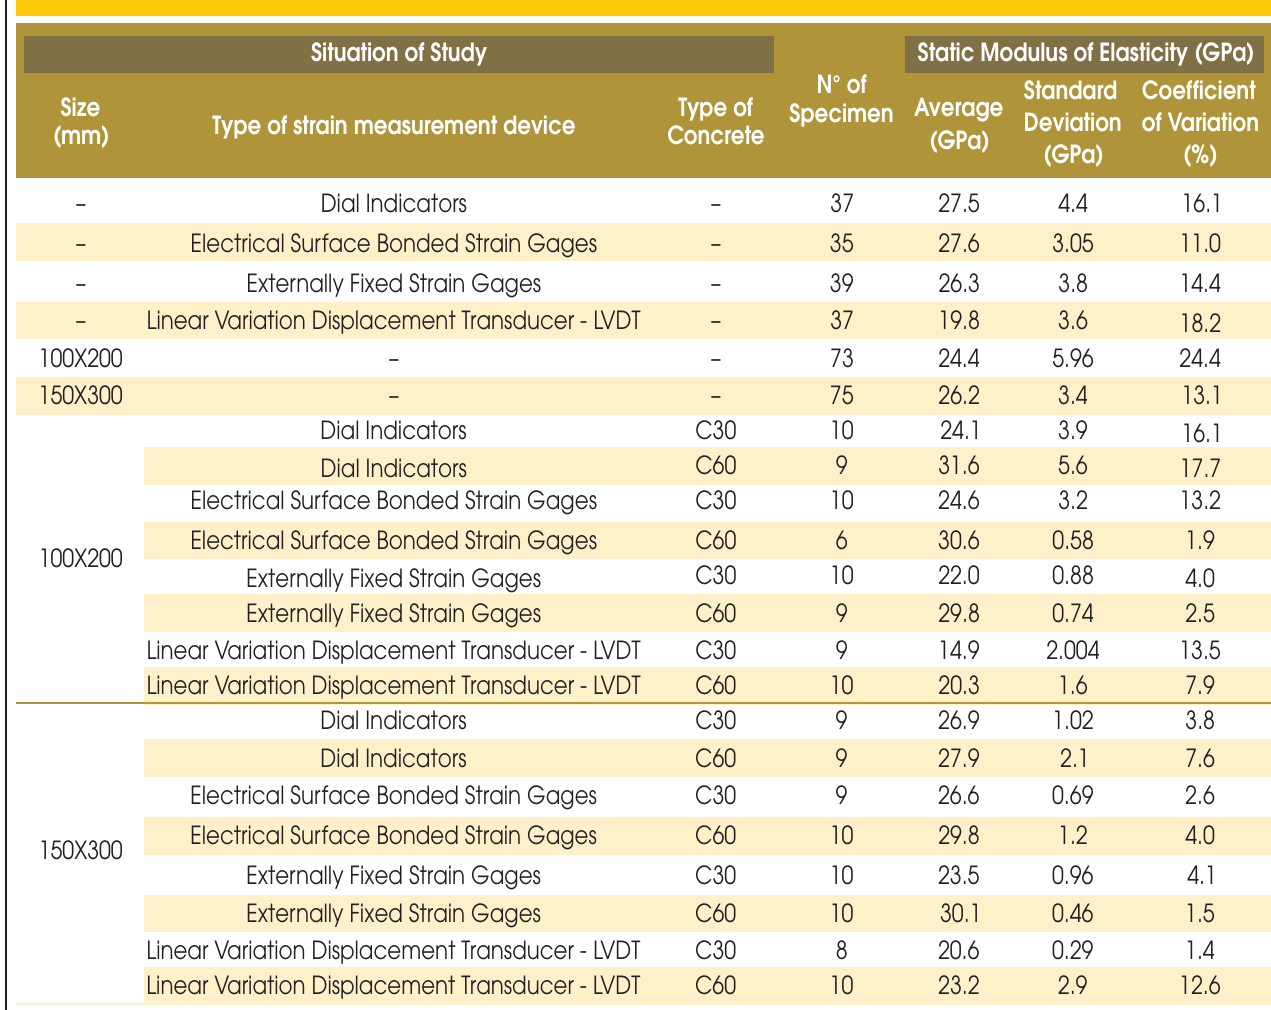
Table 4 – Statistical analysis of test results – static modulus of